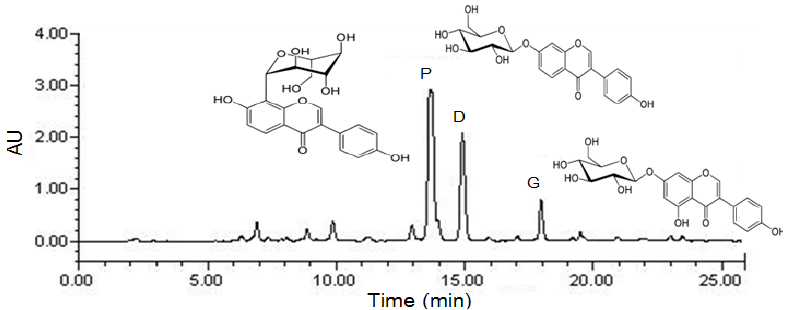
Figure 1. Preparative HPLC chromatography of PTIF. P: puerarin; D: daidzin; G: genistin; PTIF: P. lobata total isoflavones.